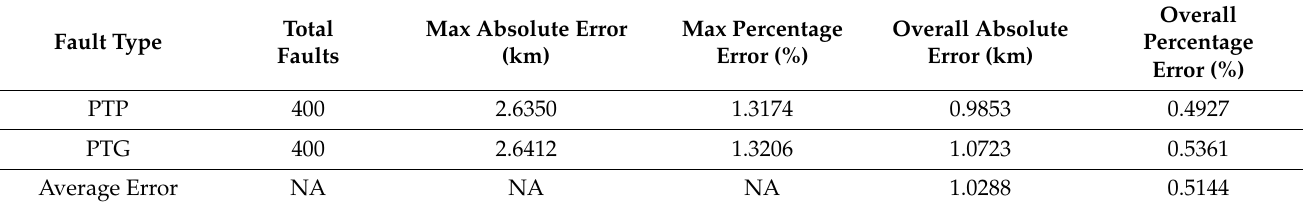
Table 8. Fault location estimation errors.